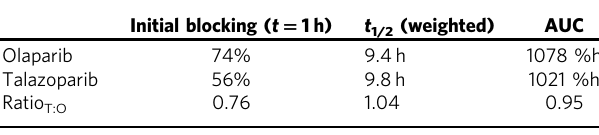
Table 2 Summary of in vivo kinetics data of olaparib and